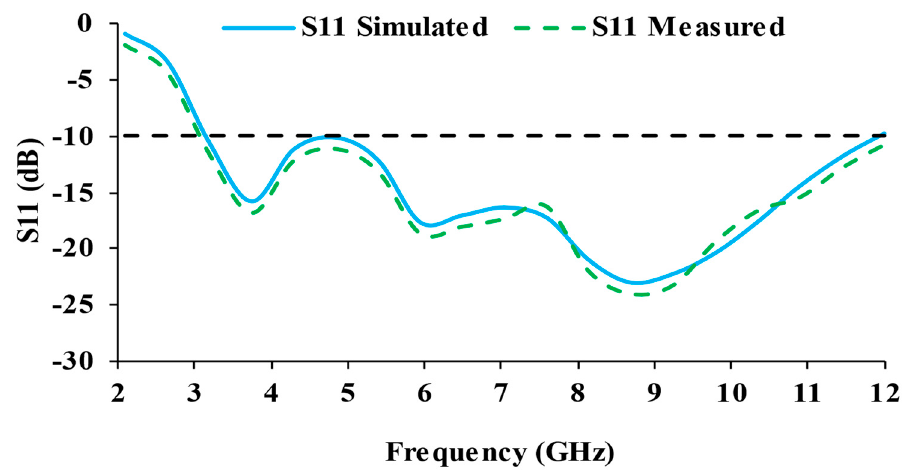
Figure 7. S 11 (dB) curves of the designed antenna.